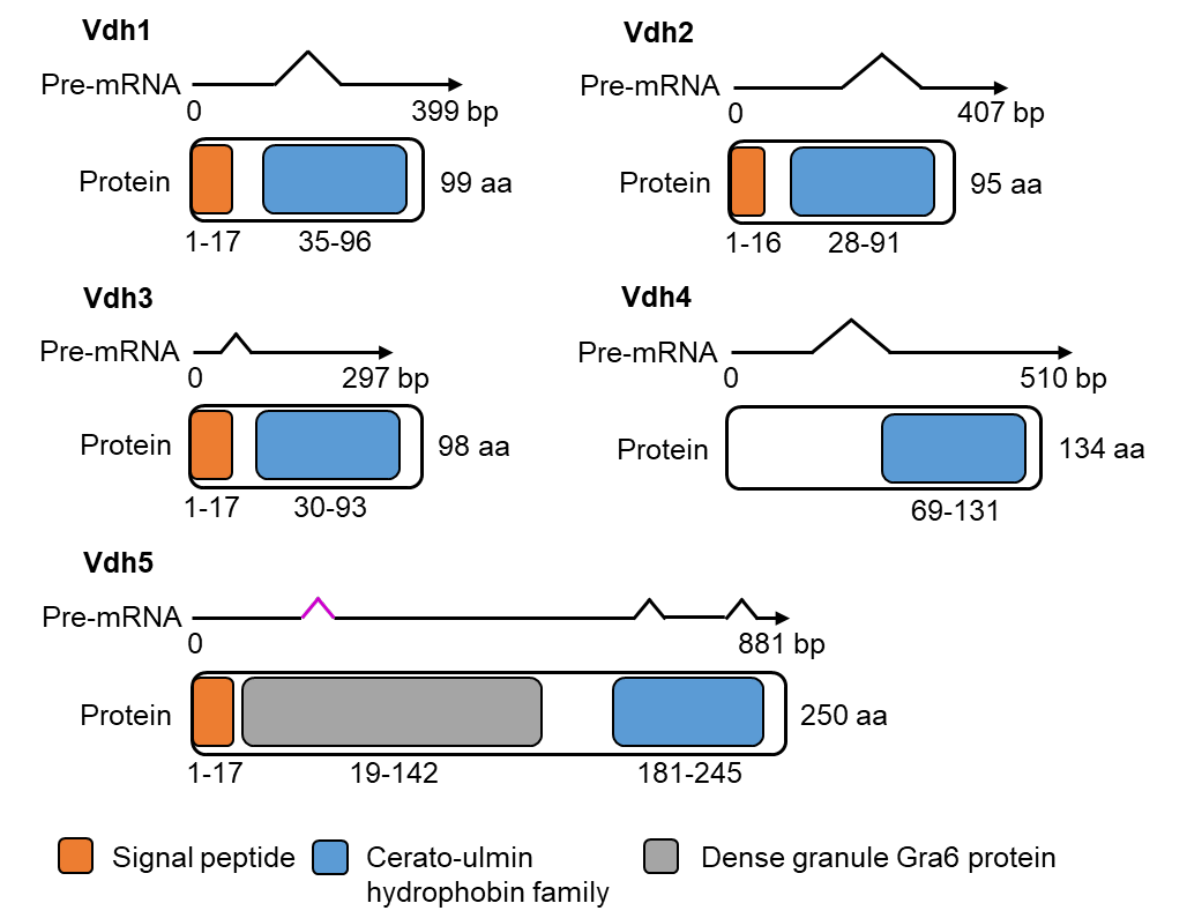
Figure 2. Transcript and protein structure of V. dahliae hydrophobins. All five hydrophobins annotated in JR2 (Vdh1: VDAG_JR2_Chr2g02500a, Vdh2: VDAG_JR2_Chr4g07990a, Vdh3: VDAG_JR2_Chr1g24880a, Vdh4: VDAG_JR2_Chr3g09420a, and Vdh5: VDAG_JR2_Chr1g24730a) contain a C-terminal domain of the cerato-ulmin hydrophobin family (IPR010636; in blue) predicted by InterPro. Vdh1, Vdh2, Vdh3, and Vdh5, but not Vdh4, additionally contain a predicted N-terminal secretory signal peptide (in orange). Vdh1, Vdh2, and Vdh3 consist of 95 to 99 amino acids (aa) encoded by open reading frames (ORF) of 297 to 407 base pairs (bp). Vdh4 is slightly larger with 134 aa encoded by a 510 bp ORF. Vdh5 represents the largest protein with 250 aa encoded by an 881 bp ORF and has an additional predicted dense granule Gra6 protein domain (IPR008119; in gray). The original Vdh5 annotation of 258 aa was corrected to 250 aa by cDNA sequencing because of an additional unpredicted intron (highlighted in purple). The cDNA sequence of VDH5 and the amino acid sequence of the deduced protein are shown in Figures S5 and S6, respectively.